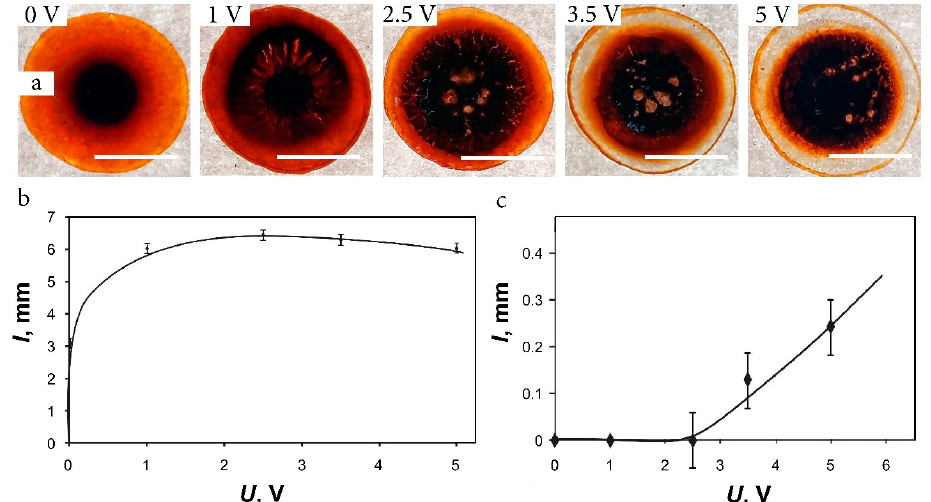
Figure 5. The architecture of the deposits formed during the evaporation of droplets of sample No. 1 under the simultaneous application of non-uniform magnetic and electric fields. The visual appearance of the deposits, formed on a negative substrate and positive needle electrode ( a ), scale bars are 4 mm; Diameter of the central spot as the function of the applied potential with simultaneous application of a magnetic field ( b ); Outer ring wideness as the function of applied potential ( c ). For the experimental points, the intervals of experimental error bars are indicated. The results are average of three measurements.